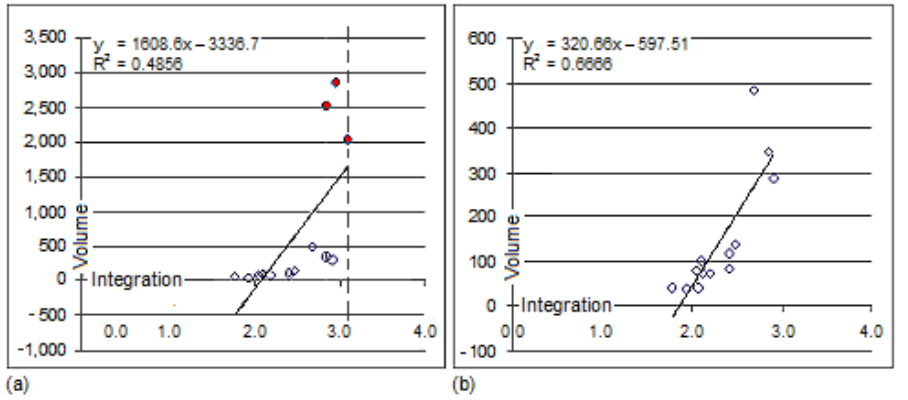
Figure 9. Scatterplots: type 2 unit-segment analysis. (a) All-roads. (b)